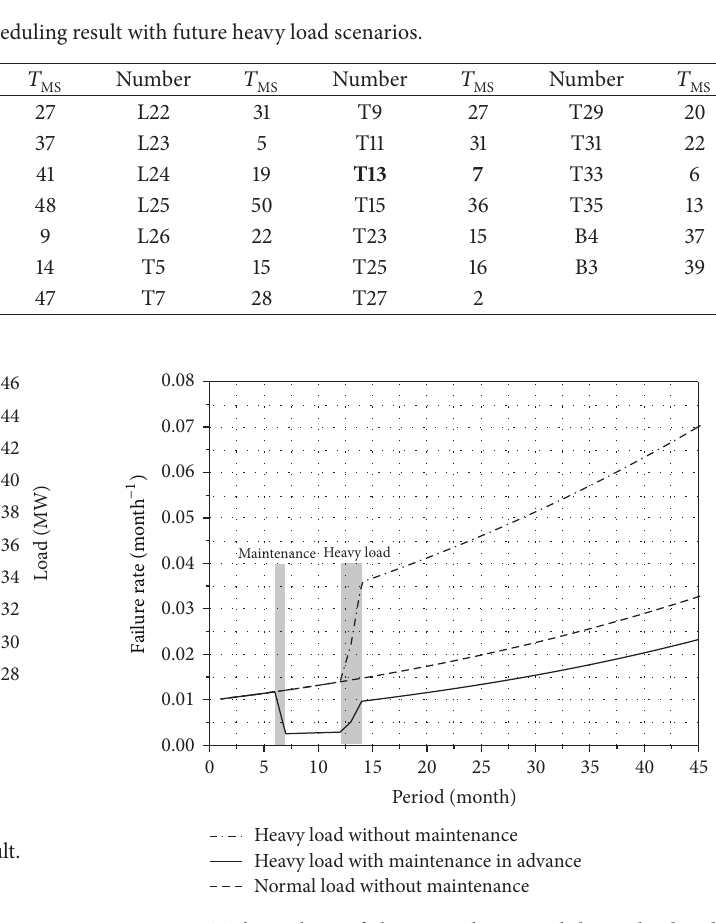
Table 5: Maintenance scheduling result ( 𝑇